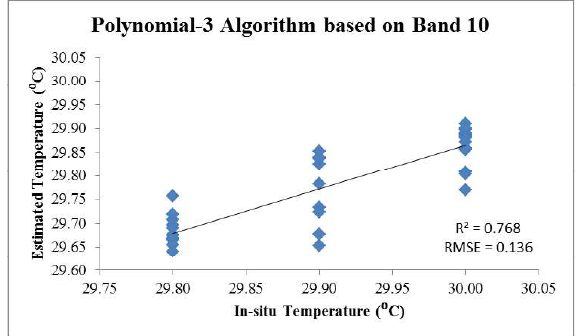
Figure 6. Band 10 Sea Surface Temperature Algorithms Performance